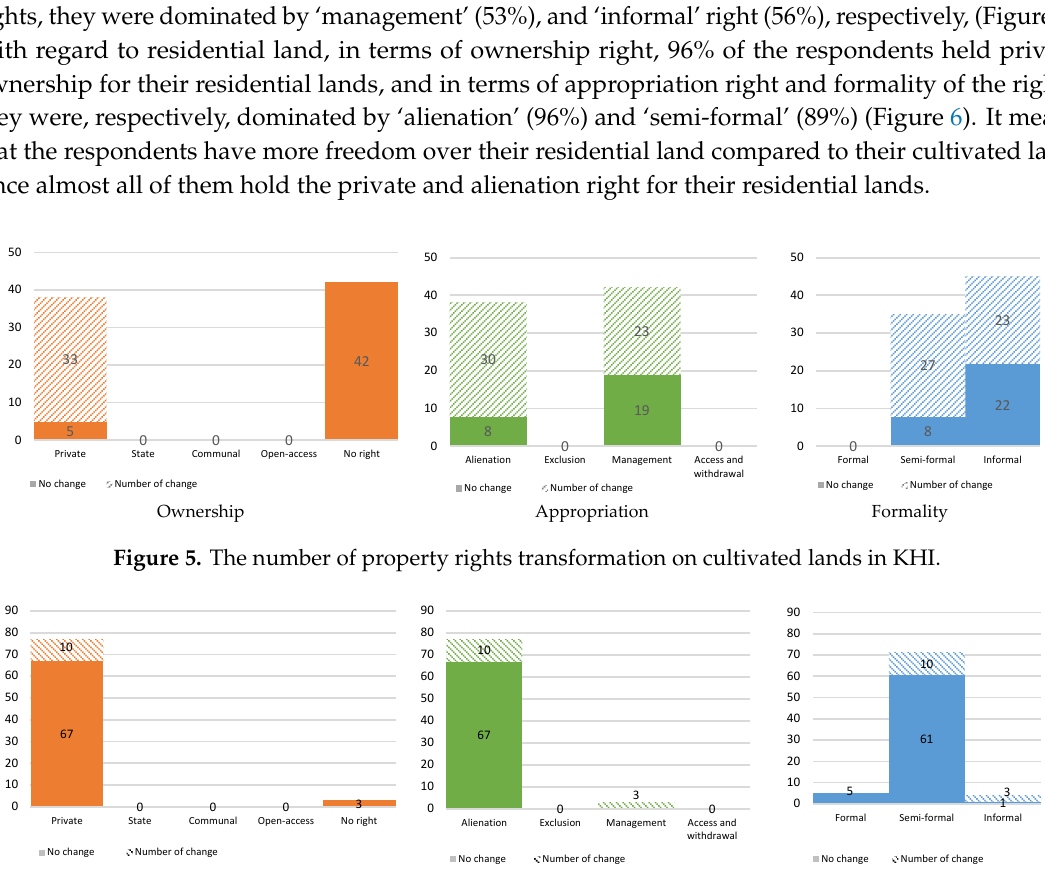
Figure 6. The number of Property rights transformation on residential lands in KHI.